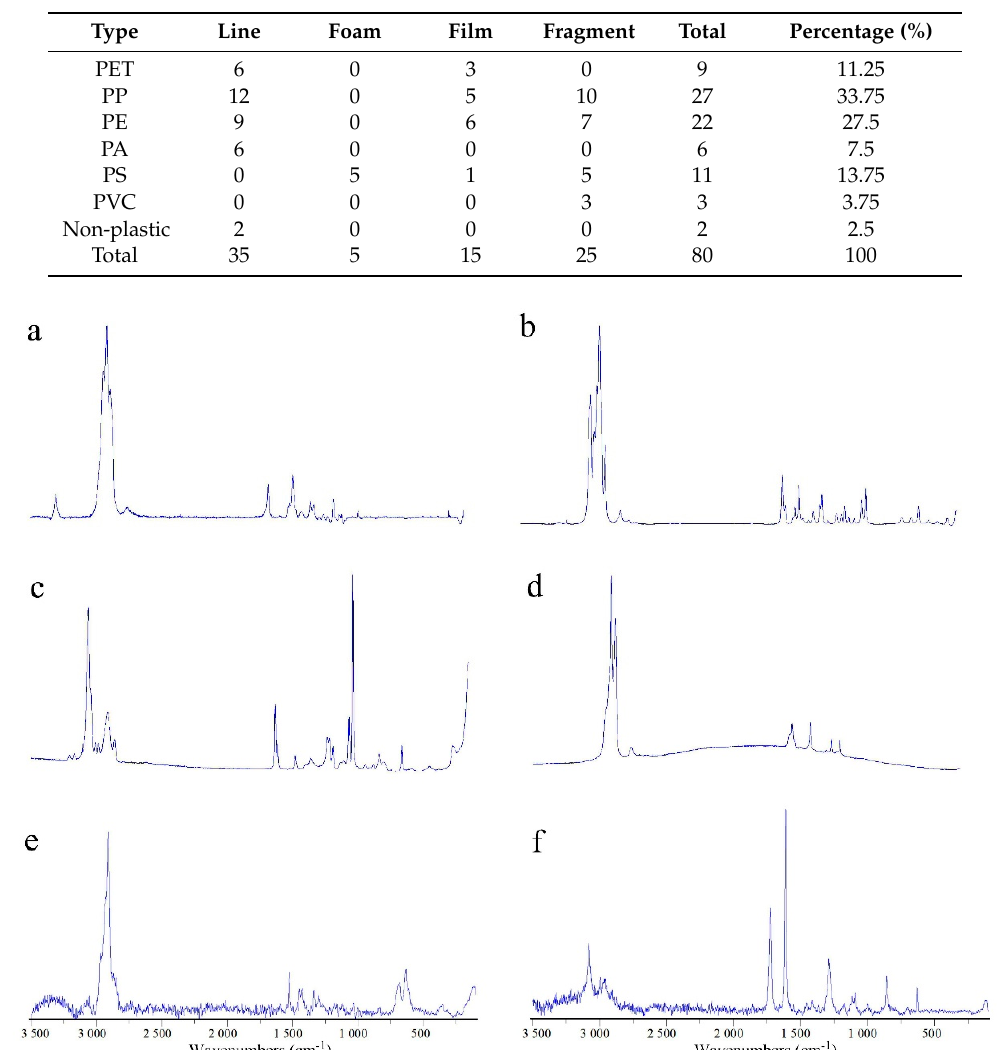
Table 2. Polymer types from the results of the micro-Raman spectroscopy.